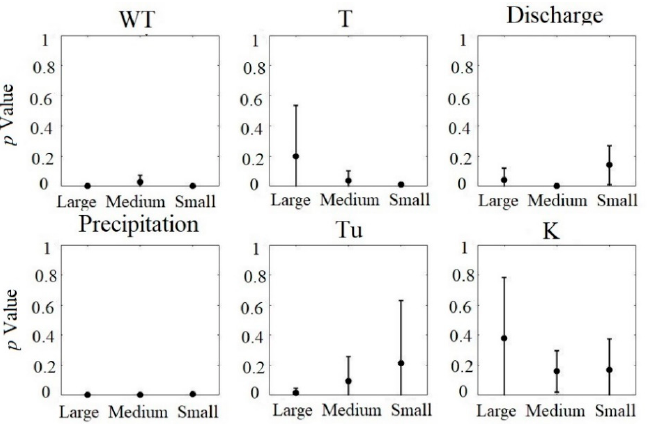
Figure 11. Box plots of p -values resulting from the Granger causality test based on watershed size (small, medium, and large) when DO is Granger caused by WT, T, discharge, precipitation, Tu, and K. Dots show the median and the vertical lines indicate +/- standard deviation.